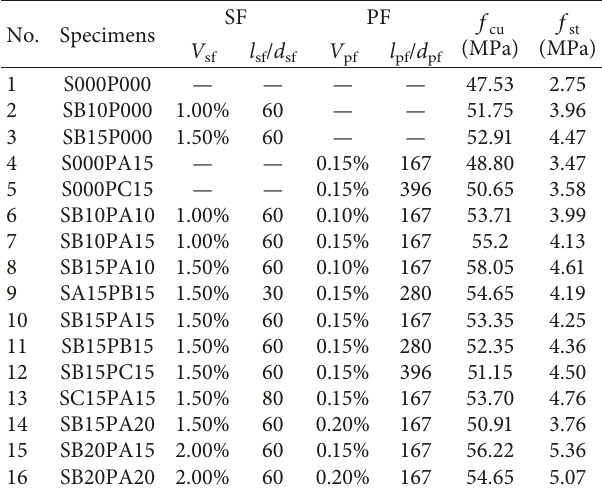
Table 3: Details of